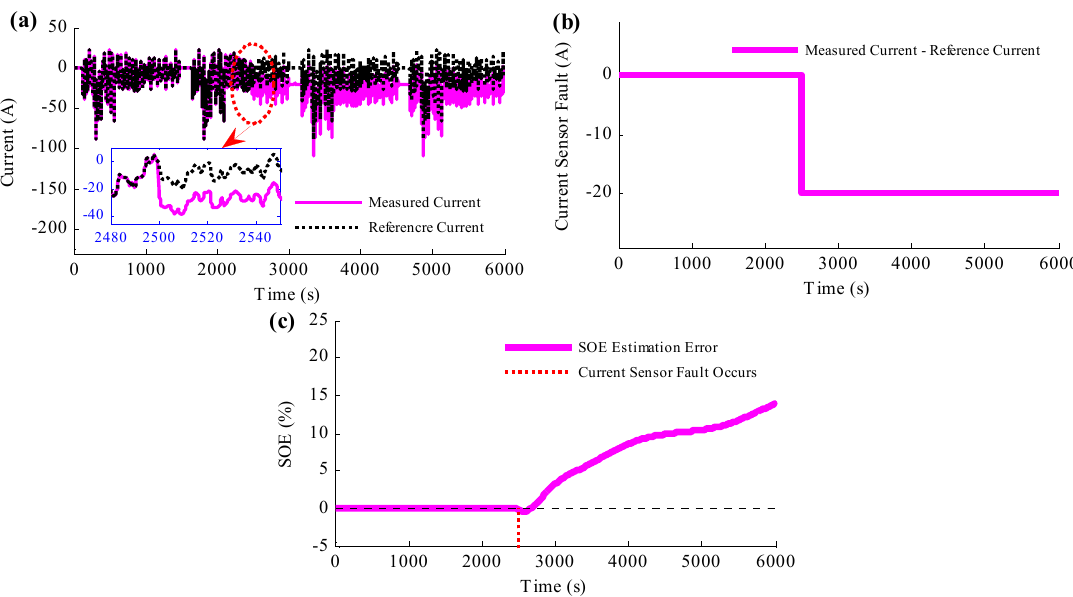
Figure 6. Simulation results when current sensor fails without taking any action: ( a ) measured current and reference current results caused by the current sensor fault; ( b ) current fault resulting from measured current minus reference current; ( c ) SOE estimation results when current sensor fault occurs and no action is taken.